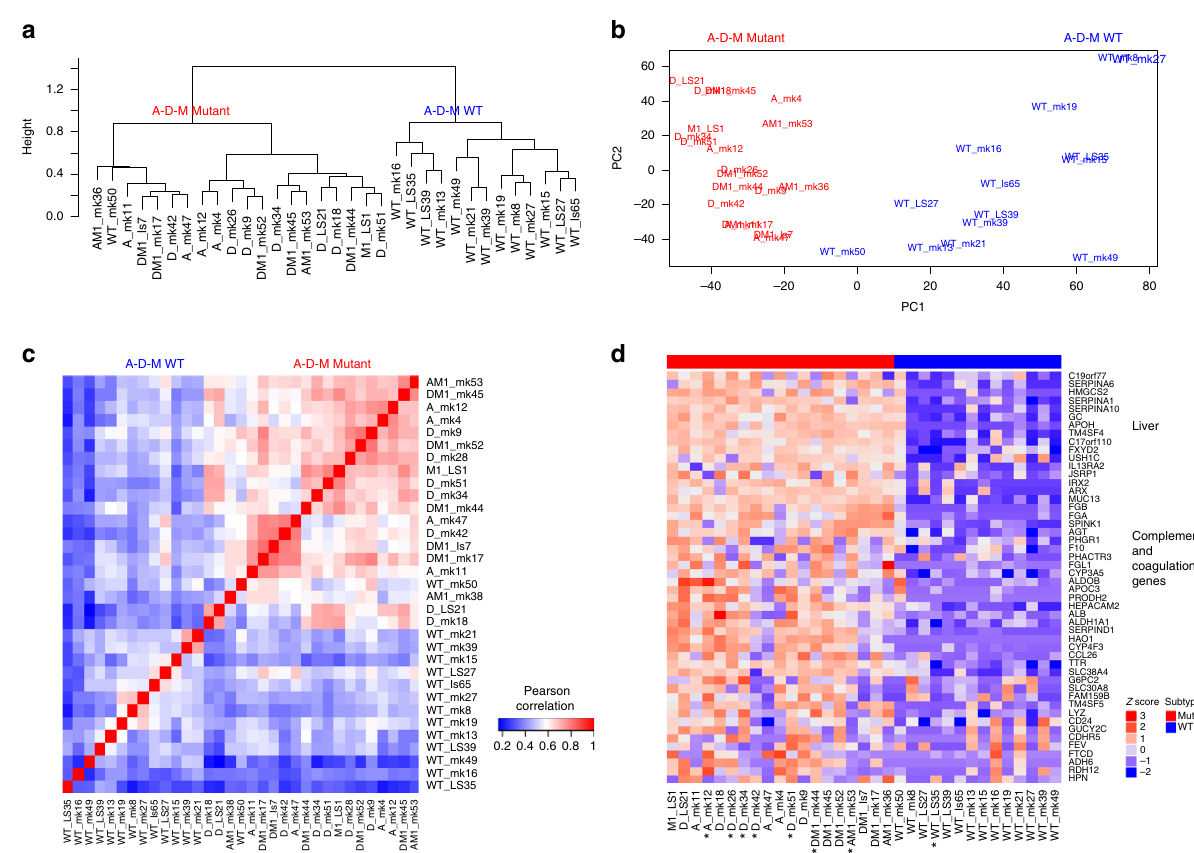
Fig. 2 A-D-M mutant and WT PanNETs as two distinct gene expression groups. a Unsupervised clustering of PanNETs using top 3000 variant genes across all samples revealed two distinct robust clusters. The two clusters almost perfectly separate A-D-M WT panNETs from A-D-M mutant panNETs. b Principal component analysis using top 3000 variant genes separated the A-D-M mutant from A-D-M WT PanNETs along the fi rst principal component (PC1). A-D-M mutant panNETs were more homogeneous in gene expression than A-D-M WT as shown by smaller variation along PC1. c Heatmap of pair- wise Pearson correlation of panNETs using top 3000 variant genes across all samples revealed a higher correlation among A-D-M mutants as compared to A-D-M WT panNETs. Red color represents higher correlation and blue represents lower correlation. d Heatmap of top variants genes showing liver, complement, and coagulation genes highly expressed in A-D-M mutant panNETs. Star (*) below sample names represent liver metastatic samples (except for A_mk12 which is a lymph